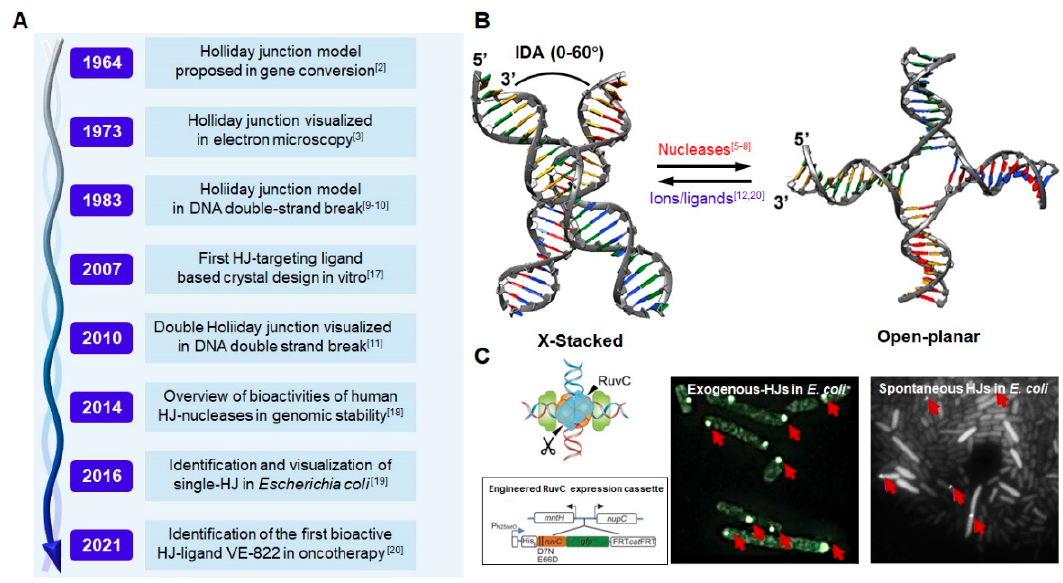
Figure 1. History, structure, and visualization of HJ. ( A ) Representative studies of HJ from 1964 to 2021. [2,3,9–11,17–20] ( B ) Schematic of two major HJ configurations termed “X-stacked” and “open-planar”, the X-stacked conformation usually exists in the condition of high concentration counter-ion (Mg 2+ ) or certain ligand, and this conformation can be converted to the “open-planar” under the process of HJ nucleases [12]. ( C ) The visualization of HJ via an engineered RuvC protein (blue triangles), which defects nuclease activity and selectively targets HJ ( left ). The fluorescent foci represent the exogenous plasmid HJ ( middle ) and spontaneous HJ in E. coli ( right ) [19].